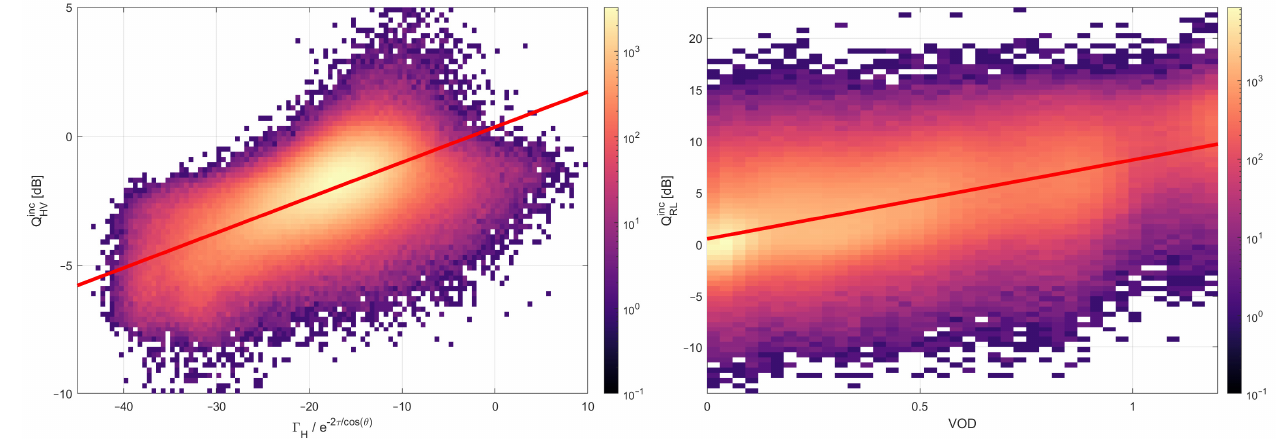
Figure 7. Sca tt er-density plots of the 𝑄 (cid:3009)(cid:3023)(cid:3036)(cid:3041)(cid:3030) and 𝑄 (cid:3019)(cid:3013)(cid:3036)(cid:3041)(cid:3030) fi ts in Equations (30) and (31). Figure 7. Scatter-density plots of the Q inc